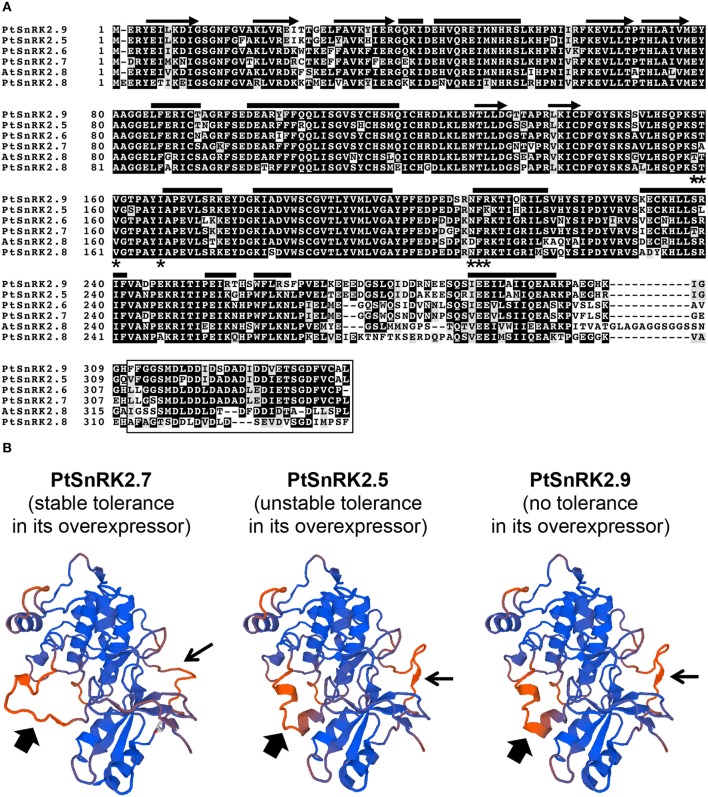
SnRK2 proteins of Populus trichocarpa (poplar, Pt), and Arabidopsis thaliana (Arabidopsis, At). (A) Amino acid sequence alignment of subclass 2 PtSnRK2 proteins with AtSnRK2.8. The residues putatively corresponding to the α-helix, β-sheet, PP2C-interaction residues, and the entire ABA box are marked by bars, arrows, asterisks, and the box, respectively. (B)
In silico modeling of the three-dimensional structures of PtSnRK2.5, PtSnRK2.7, and PtSnRK2.9 proteins. Homology modeling was performed based on the crystal structure of AtSnRK2.6 using the web-based SWISS-MODEL service (http://swissmodel.expasy.org/workspace/; Arnold et al., 2006). Thick and narrow arrows indicate regions presumed to differ in their three-dimensional architecture among the PtSnRK2 proteins because of differences in amino acid sequences.